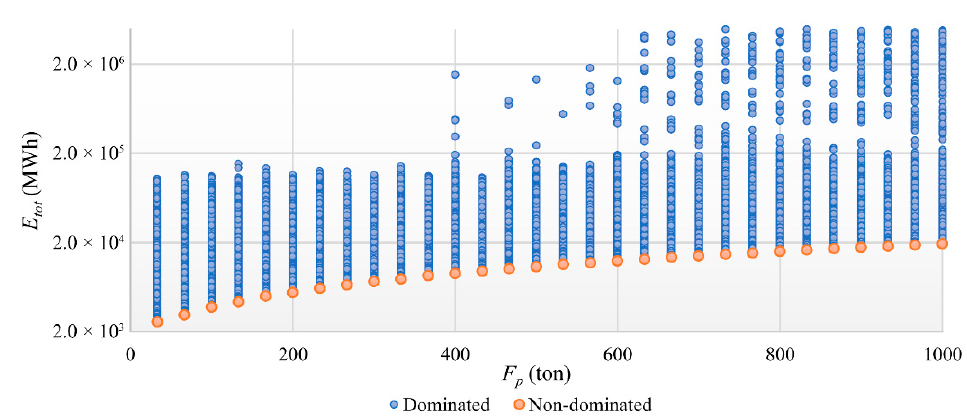
Figure 23. Search space and optimisation results of multi-objective algorithms.